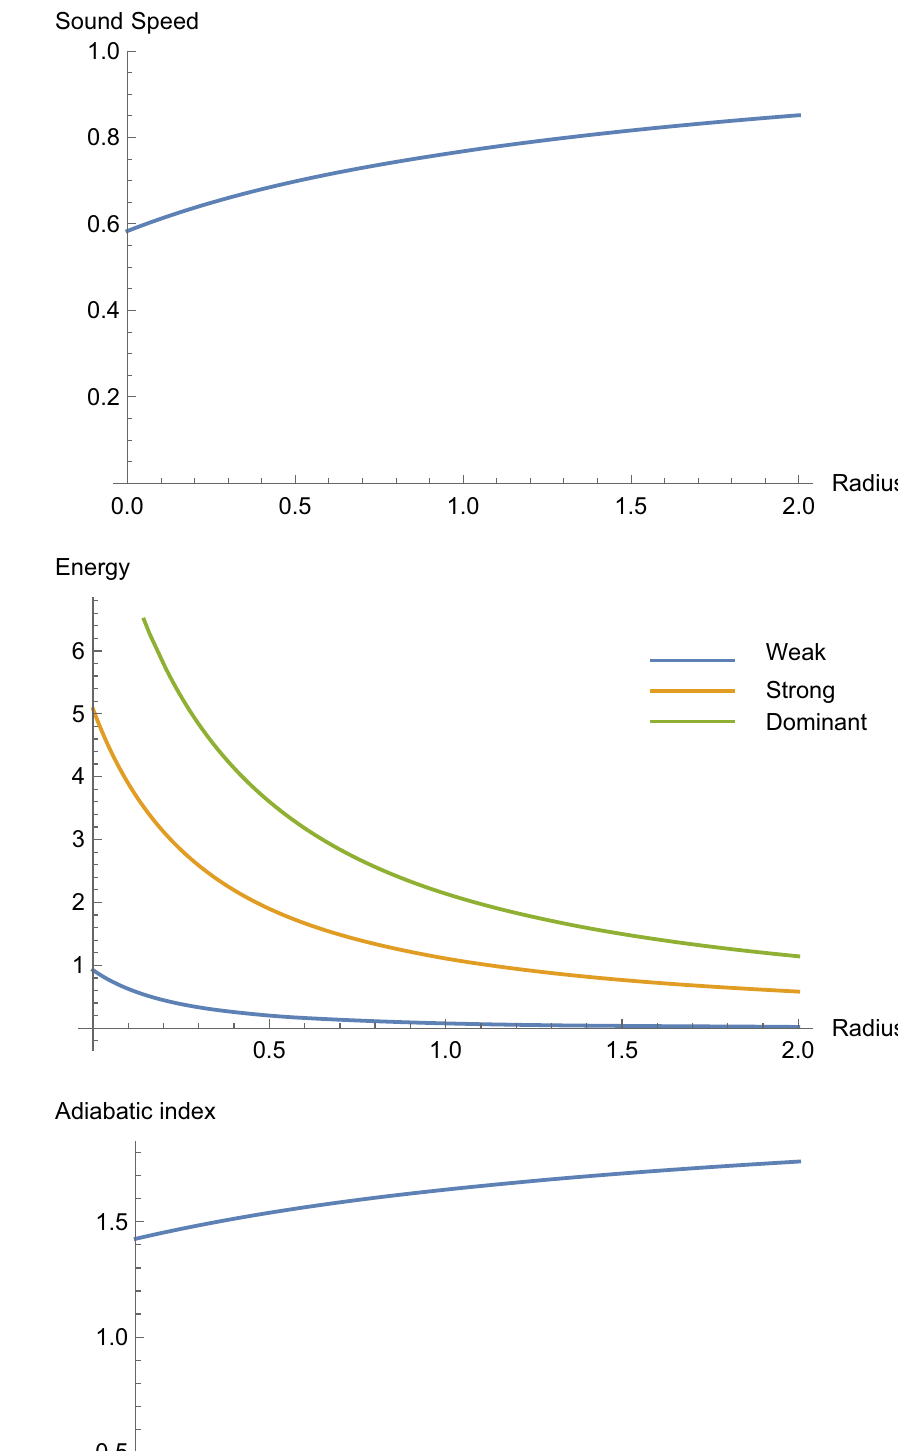
Fig. 15 Chandrasekhar adiabatic stability index versus the radial variable